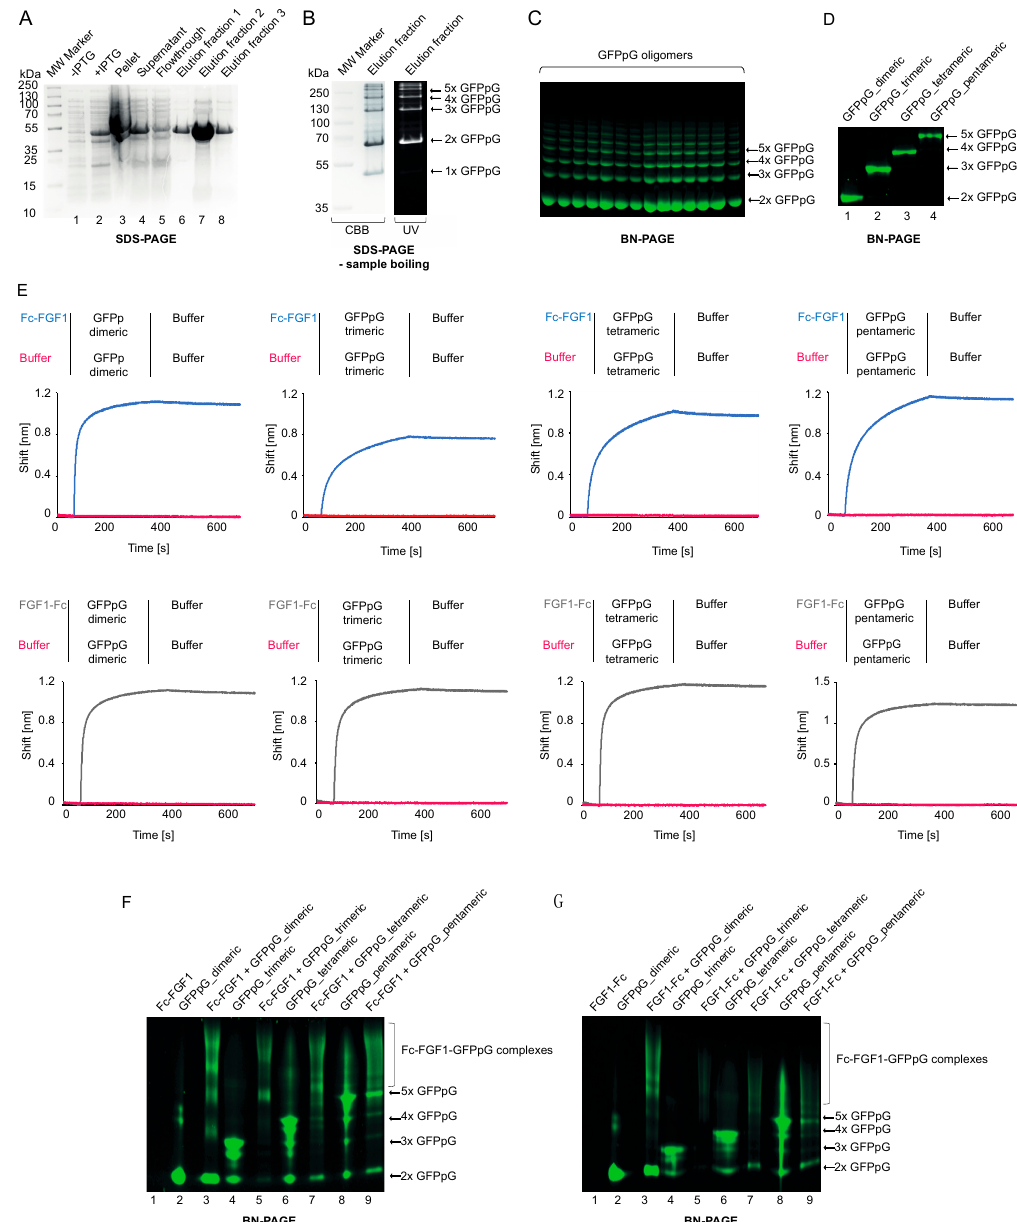
Figure 5. Preparation of GFPpG oligomers. ( A – C ). The mixture GFPpG oligomers was purified by nickel affinity chromatography and analyzed using SDS-PAGE (CBB staining). ( A ) Non-boiled GFPpG preparation were analyzed by SDS PAGE and visualized with CBB/fluorescence. ( B ) The assembly of GFPpG oligomers was assessed by BN-PAGE under UV light. ( C , D ) Purity of isolated GFPpG oligomers monitored with BN-PAGE. ( E ) Evaluation of Fc-FGF1 and FGF1-Fc interaction with GFPpG oligomers with BLI. FGF1 variants were chemically immobilized on BLI sensors and incubated with each GFPpG oligomer. Association and dissociation profiles were measured. ( F , G ) Complex formation between FGF1 fusions with the Fc and GFPpG oligomers. Recombinant proteins: Fc-FGF1 and FGFG1-Fc and various GFPpG variants (from dimer to pentamer) were mixed and incubated for 5–10 min at RT. Then, proteins mixture was subjected to BN-PAGE analysis under UV light.